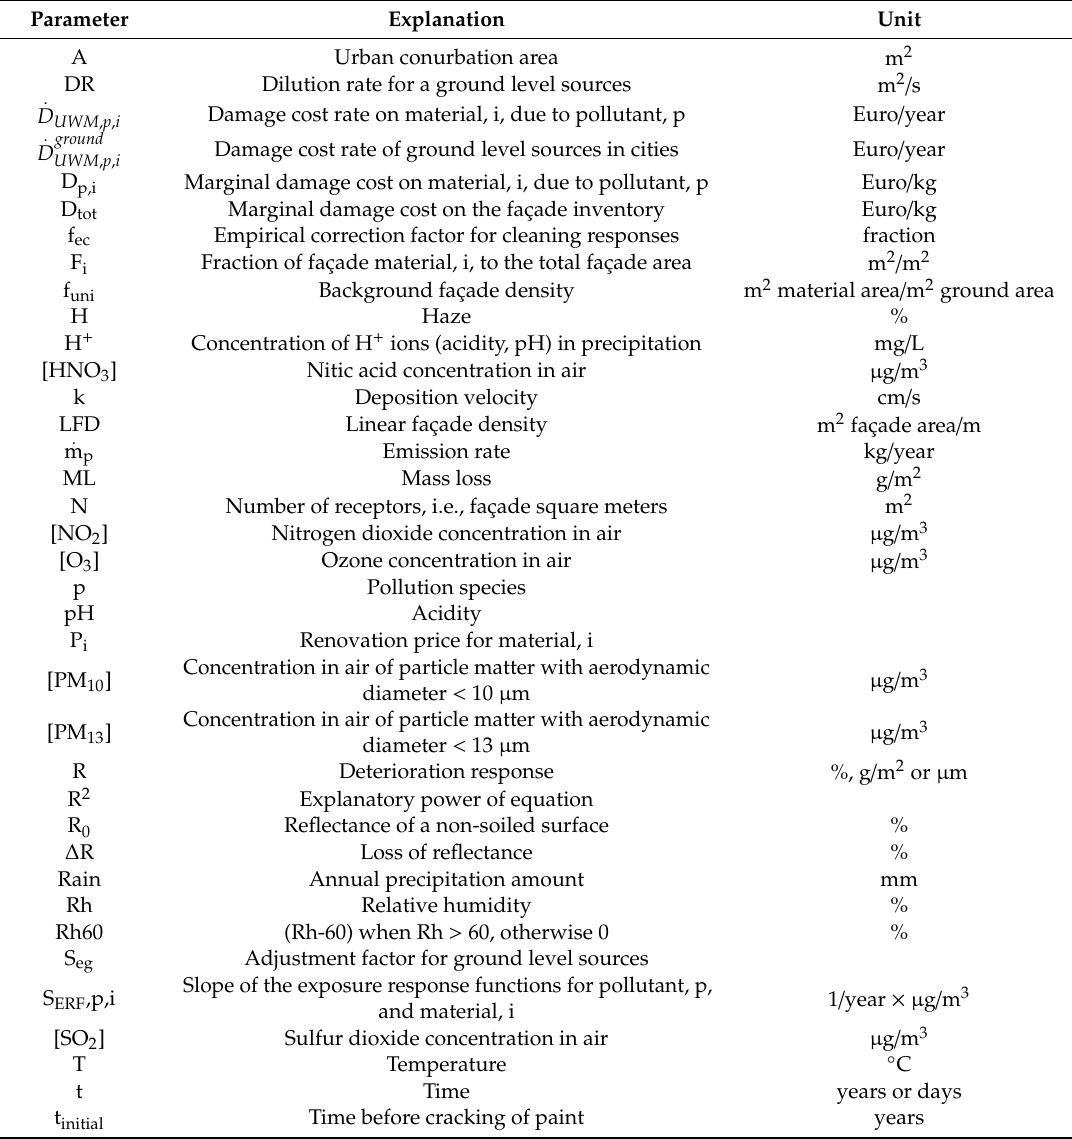
Table A1. Parameters and